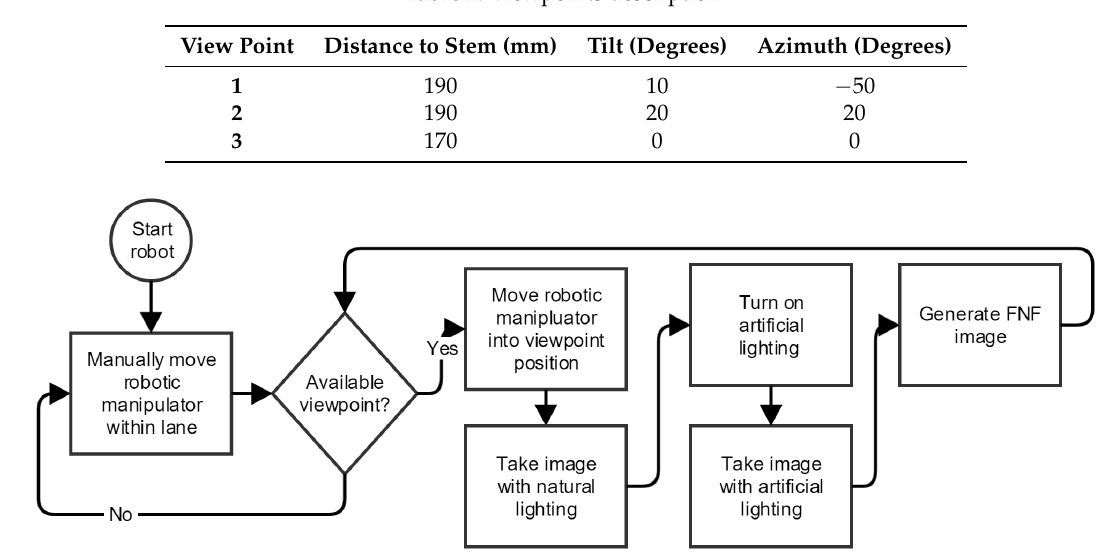
Figure 6. Data acquisition